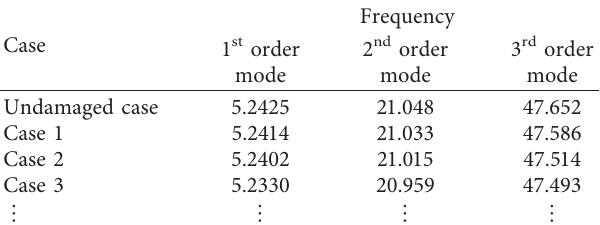
Table 2: Modal frequencies of damage